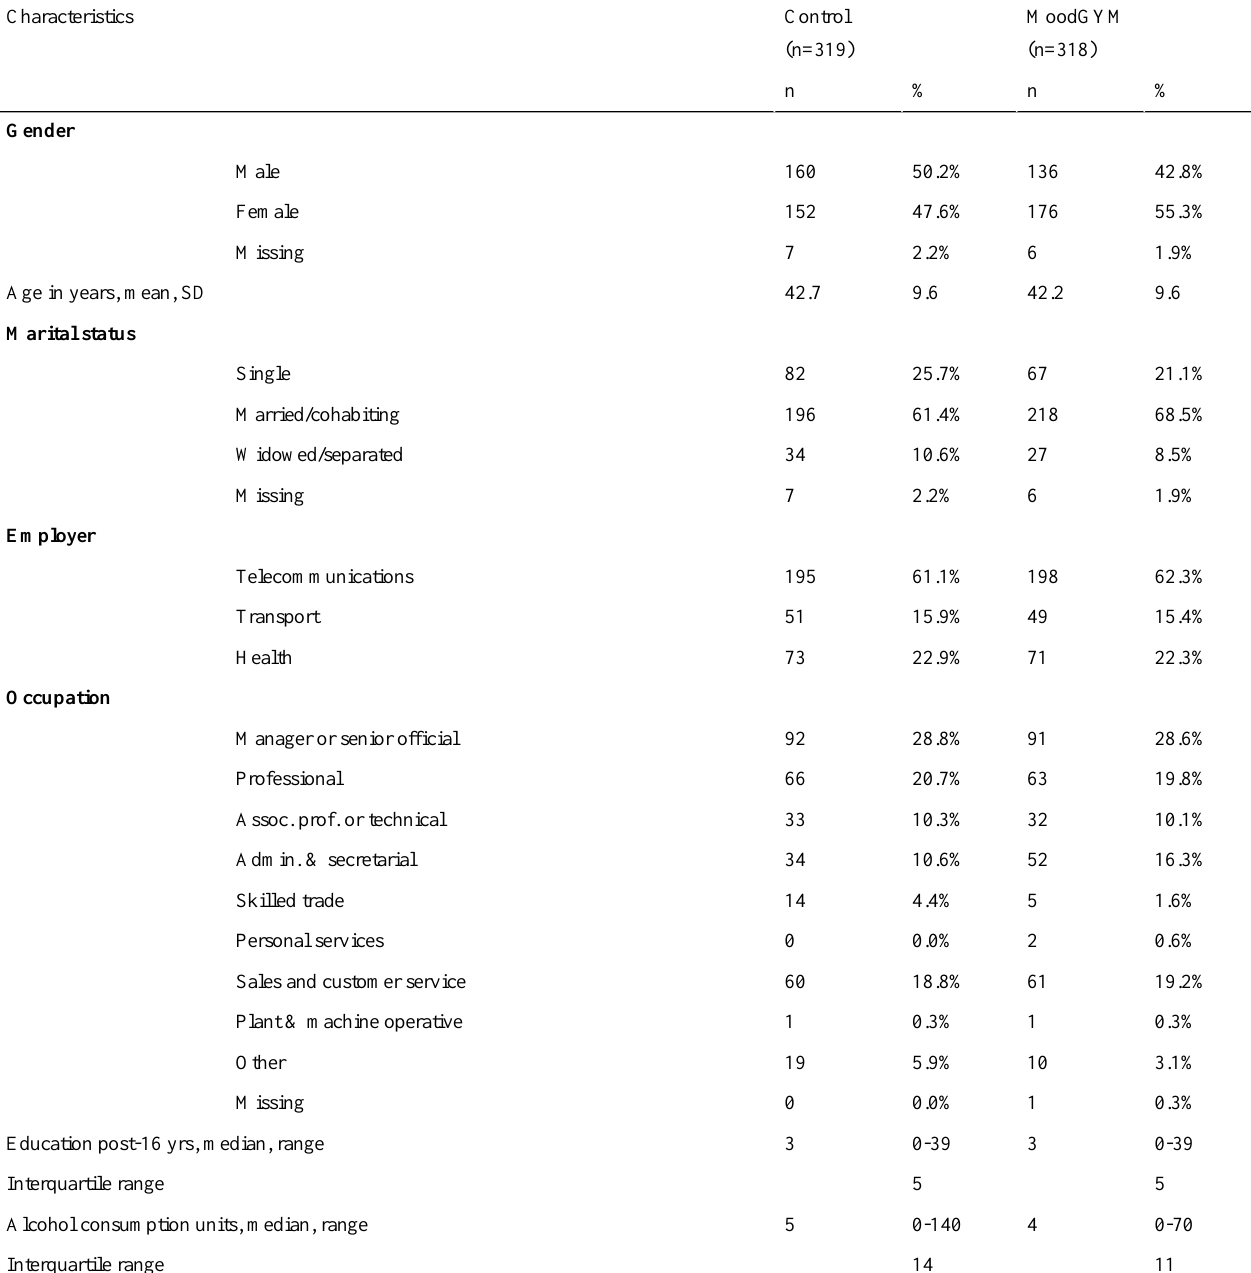
Table 1. Characteristics of subjects according to trial